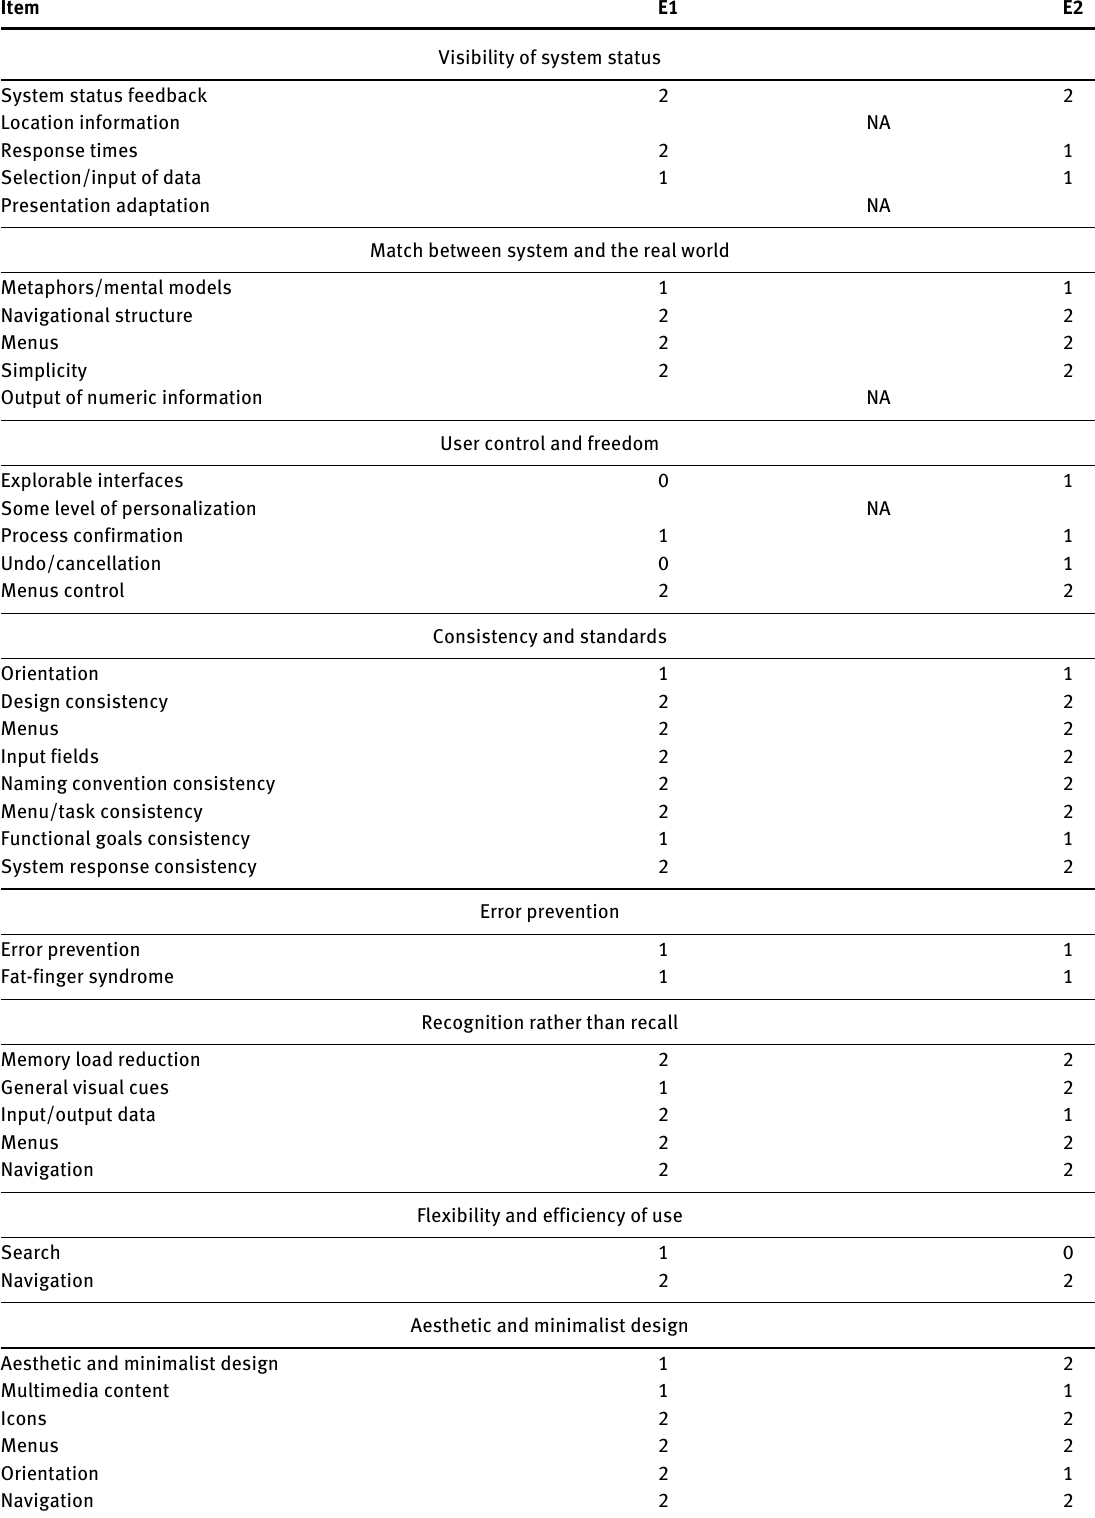
Table 2: Expert-based evaluation